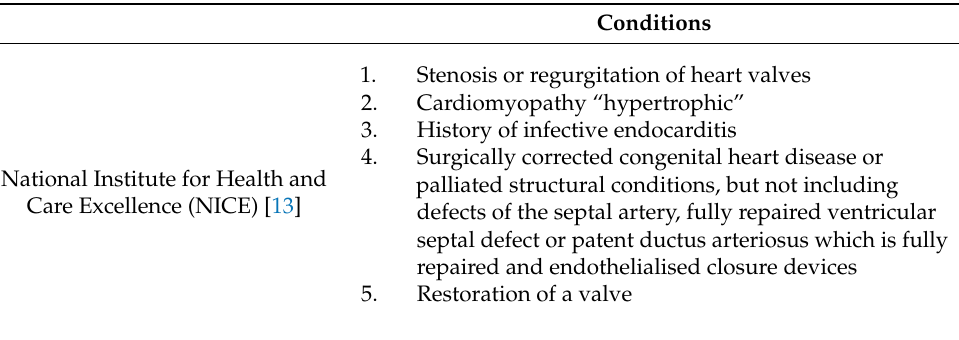
Table 3. High-risk patients for developing infective